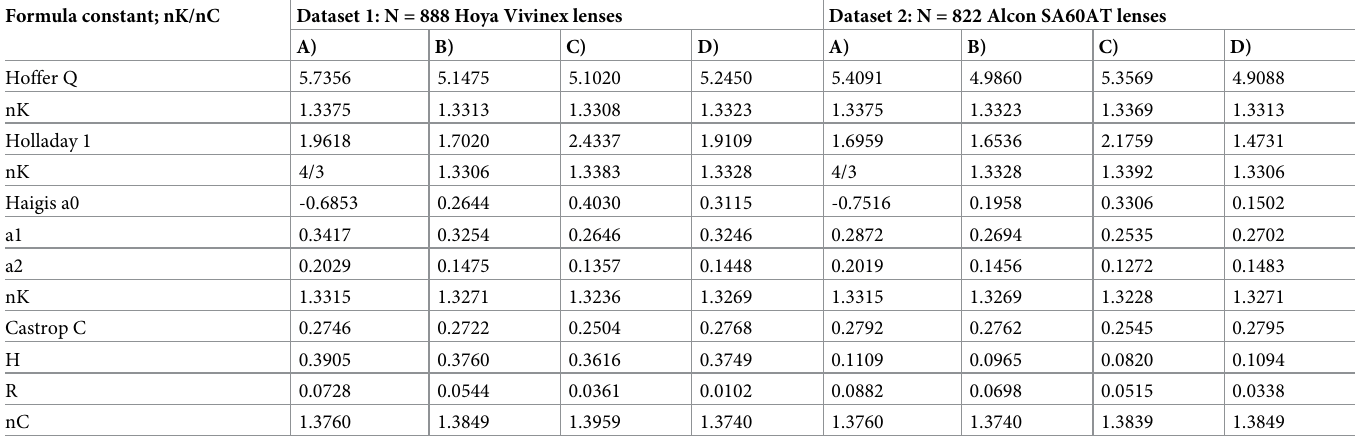
Table 2. Optimised formula constants for the Hoffer Q (pACD), the Holladay 1 (SF), Haigis (a0/a1/a2), and Castrop formula (C / H / R). Formula constant optimi- sation was performed to minimise the sum of squared prediction errors PE. A) refers to the ‘classical’ formulae with standard nK/nC values, with B) the formula constants and nK/nC in the main part of the formula were varied for optimisation, with C) the formula constants and nK/nC in the main part of the formula were varied to minimise for PE and the PE trend error over corneal radius, and with D) a standard optimisation was performed using the nK/nC value from situation B) derived from the other dataset in terms of a cross-validation.